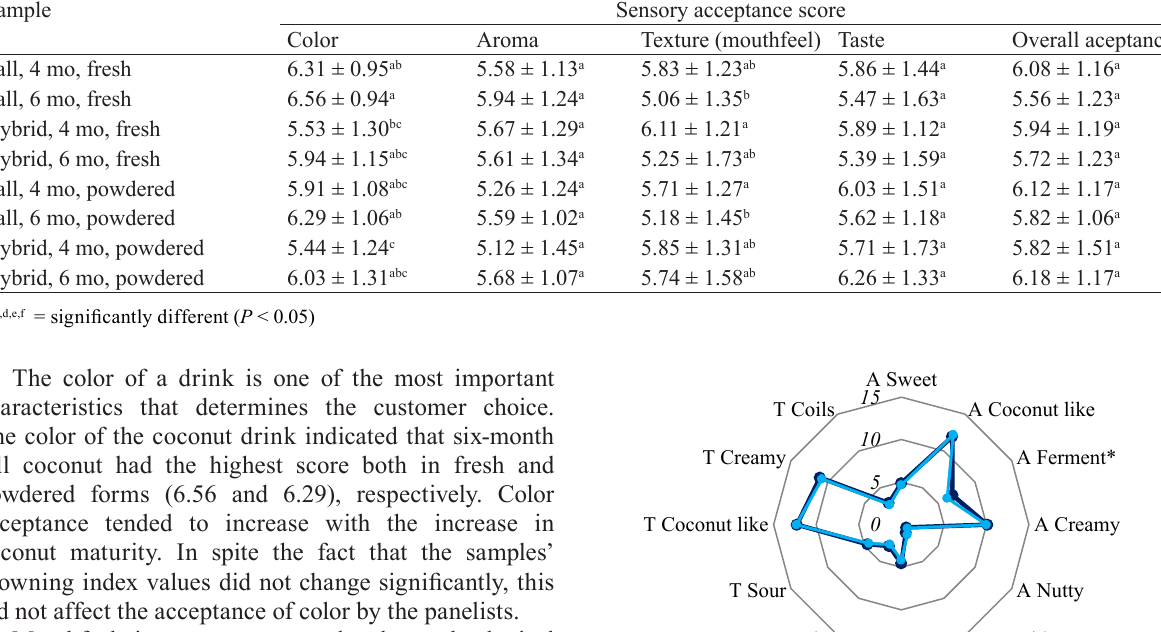
Table 4 Effect of variety and maturity age of coconut on sensory acceptance of fresh and powdered coconut drinks (mean ± SD) Sample